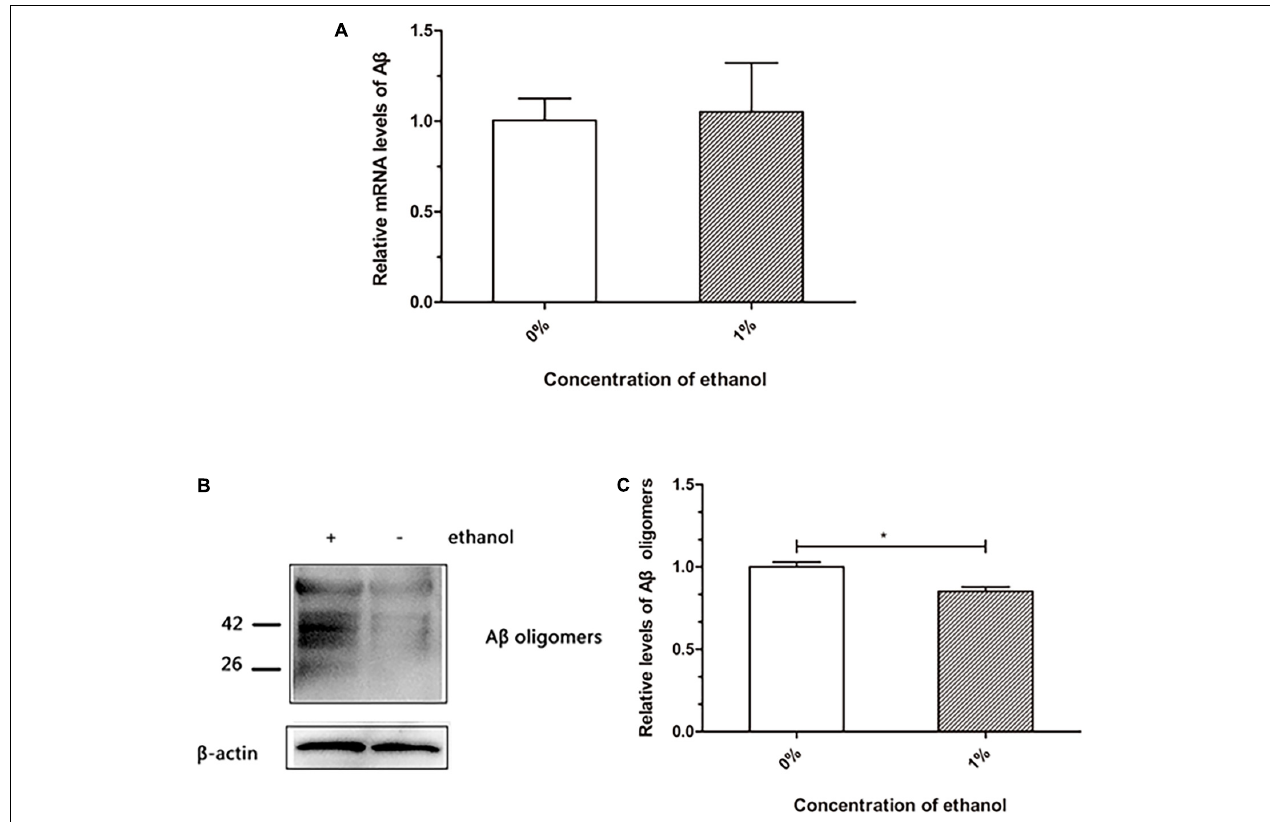
FIGURE 2 | Effect of ethanol on A β production and aggregation of C. elegans . (A) Relative A β mRNA level was determined by using quantitative real-time PCR, n = 500. (B) A β oligomers were determined by western blot, n = 1,000. (C) The relative level of A β oligomer expression was quantified by Image J software. The bar graph represents mean ± SD. * p <